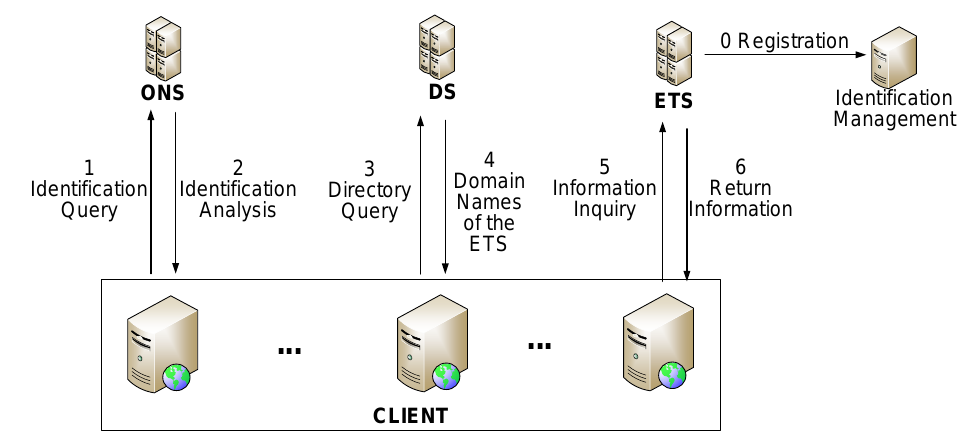
Figure 2. The operation process of the traceability service platform.